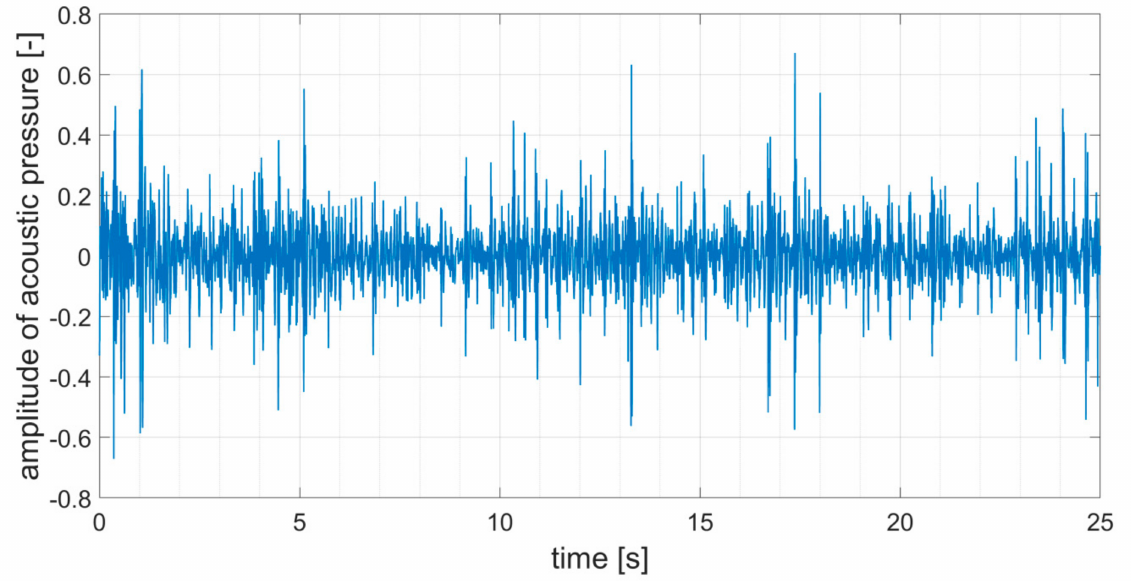
Figure 3. Unfiltered respiratory sound of a healthy female participant-Patient No. 1. Recorded at jugulum, age 13 years old, without bronchial obstruction. Chaotic progress of the acoustic pressure due to the noise in the sound. The phonendoscope Littmann 3200 records the amplitude of the acoustic pressure as a relative quantity normalized to maximum value 1. The amplitude of the acoustic pressure is therefore in arbitrary